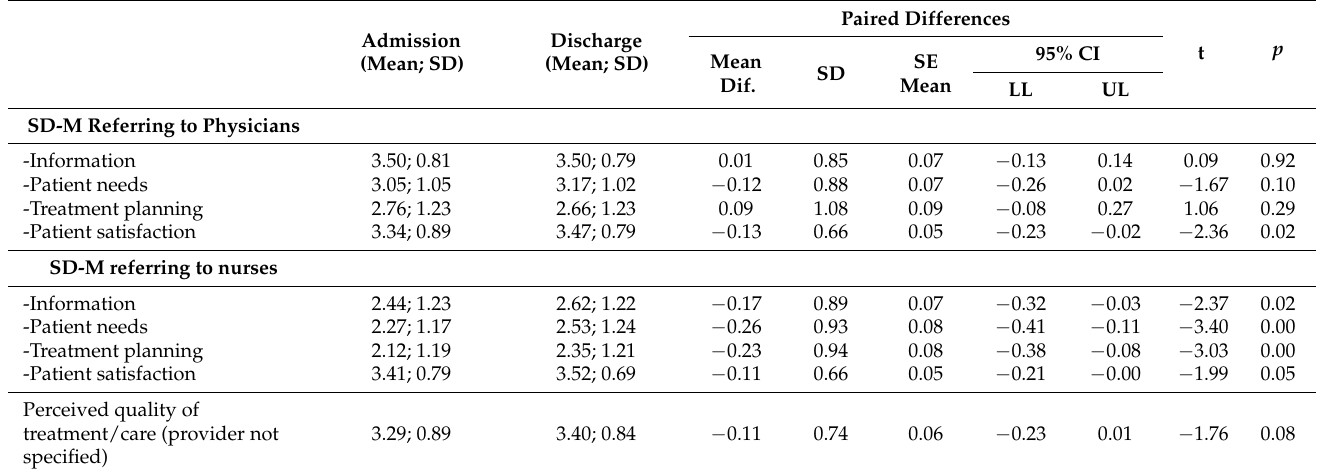
Table 1. Paired sample test comparing patients’ scores from admission to